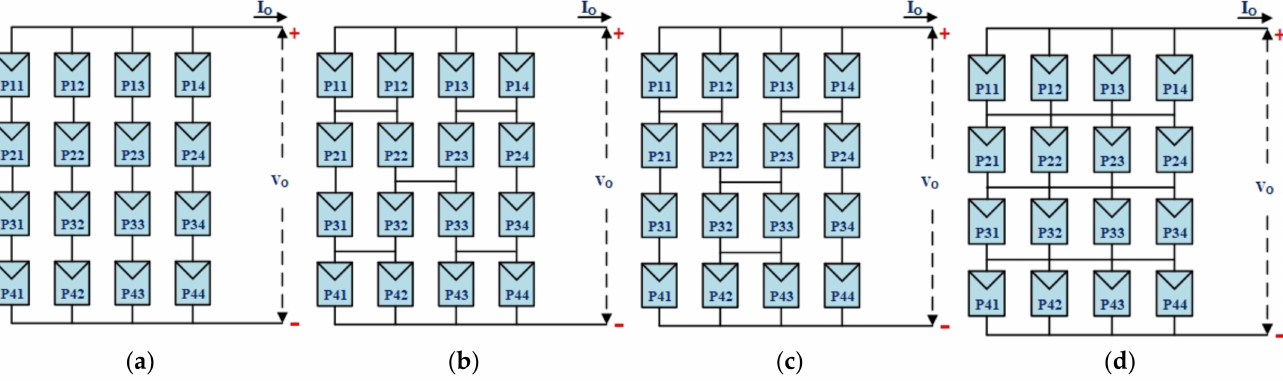
Figure 1. Different PV array configurations: ( a ) series parallel; ( b ) bridge link; ( c ) honeycomb; ( d ) total cross